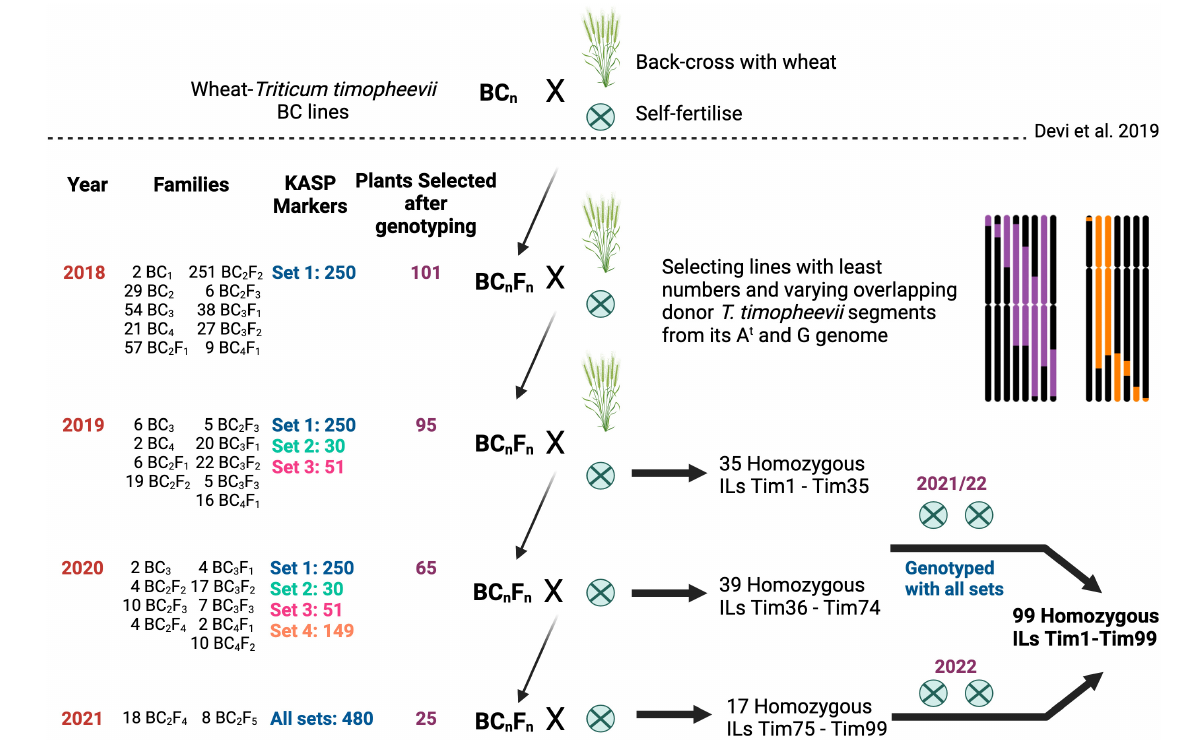
FIGURE 1 | Breeding scheme used to generate homozygous wheat- Triticum timopheevii introgression lines (ILs) from advanced backcrossed lines generated by Devi et al. (2019). For each year (one generation per year), the number of families, Kompetitive allele specific PCR (KASP) marker sets assessed, selected plants, and type of cross are shown. The backcrosses with the recurrent parents are represented by an × and a wheat plant, and the self-fertilisation rounds by an encircled × . In each year a set of homozygous ILs were selected for additional rounds of self-fertilisation to create a panel of plants carrying overlapping T. timopheevii segments of varying